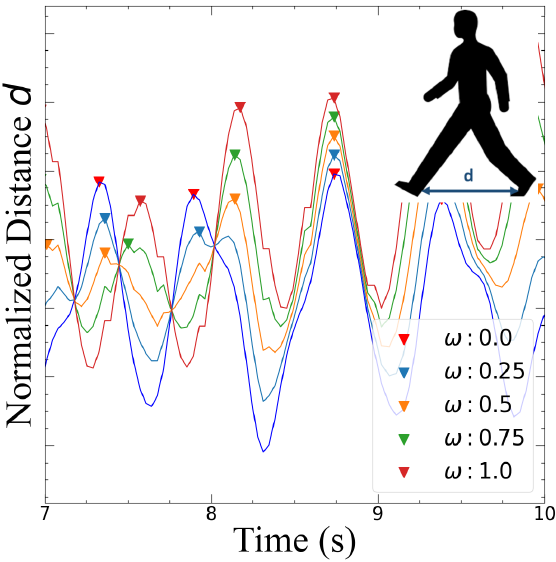
Figure 5. Example of generation of synthetic data using a linear combination of a Parkinsonian and normal gait.